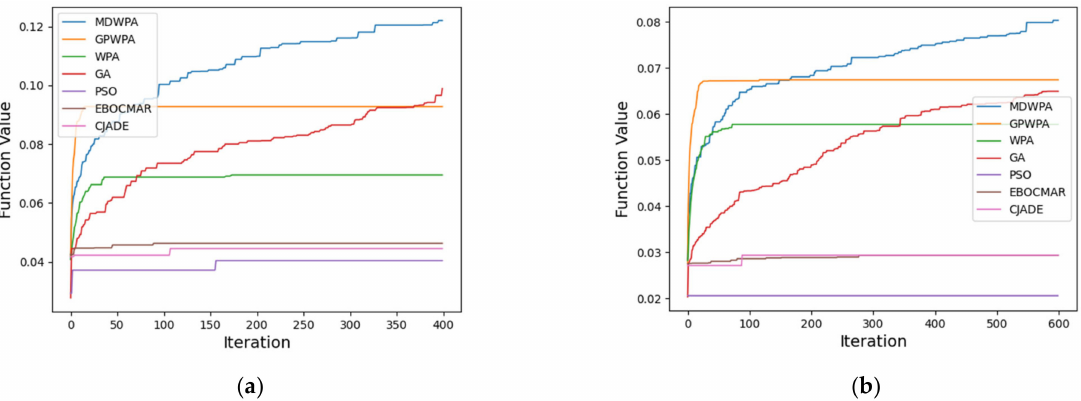
Figure 9. Comparison of iterative curves of algorithms on test cases. ( a ) is the comparison of iterative curves of algorithms on Example 2; ( b ) is the comparison of iterative curves of algorithms on Example 3.